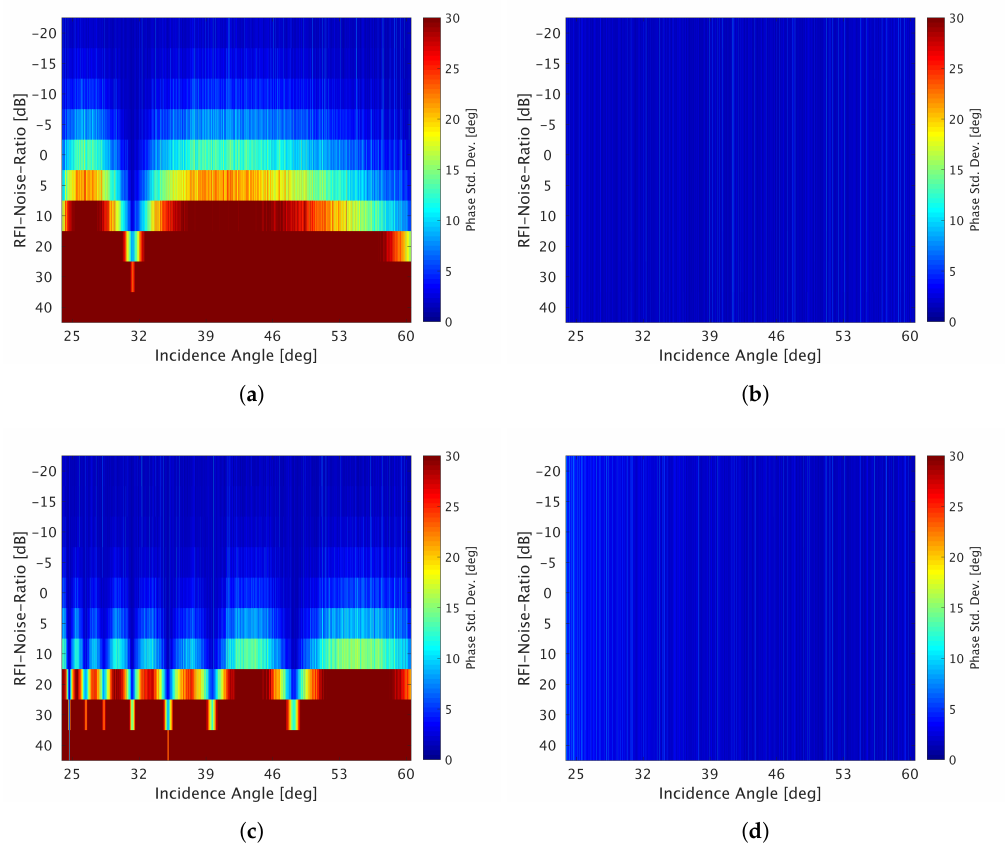
Figure 23. The phase standard deviation of the residual error image of scenario A for different RFI-Noise-Ratios versus the incidence angle of the instantaneous SAR signal. The SNR is 37.36 dB. ( a ) No RFI mitigation for N = 8, ( b ) After RD-Frequency MVDR beamforming for N = 8, ( c ) No RFI mitigation for N = 32, ( d ) After RD-Frequency MVDR beamforming for N =